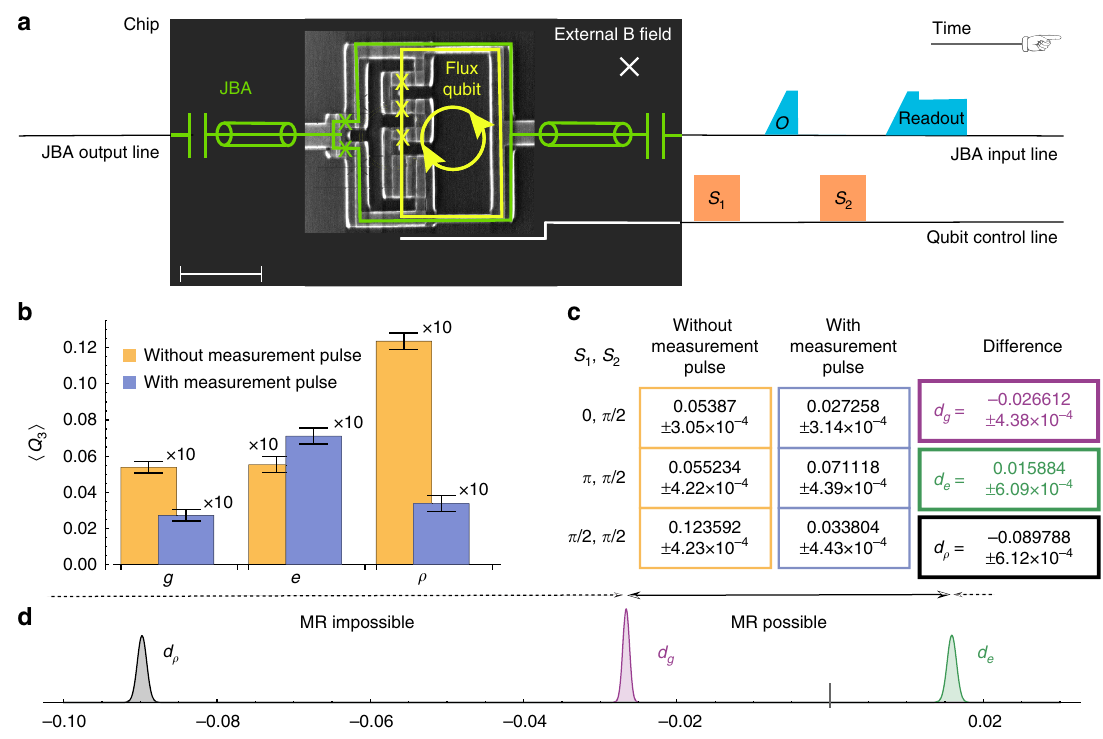
Figure 2 | Experimental setup and results. ( a ) Our superconducting flux qubit (yellow) is a micrometre scale device, features three Josephson junctions (crosses), is controlled with microwave pulses (orange) and is readout through magnetic coupling to a Josephson Bifurcation Amplifier (JBA, green) driven by a modulated voltage (blue). Pulses not to scale. ( b ) The expectation value of the final measurement with and without the measurement pulse O , for the three preparations g , e , and r (represented by a S 1 pulse angle of 0, p and p /2 respectively, see Fig. 1). The error bars represent 10 s.d. ( c ) The difference between the expectation values is our measure of the disturbance of the operation at t 2 . The measure is more negative for a quantum preparation ( r ) than for either classical preparation ( g or e ). ( d ) d r violates the macrorealist (MR) bound with a high degree of statistical